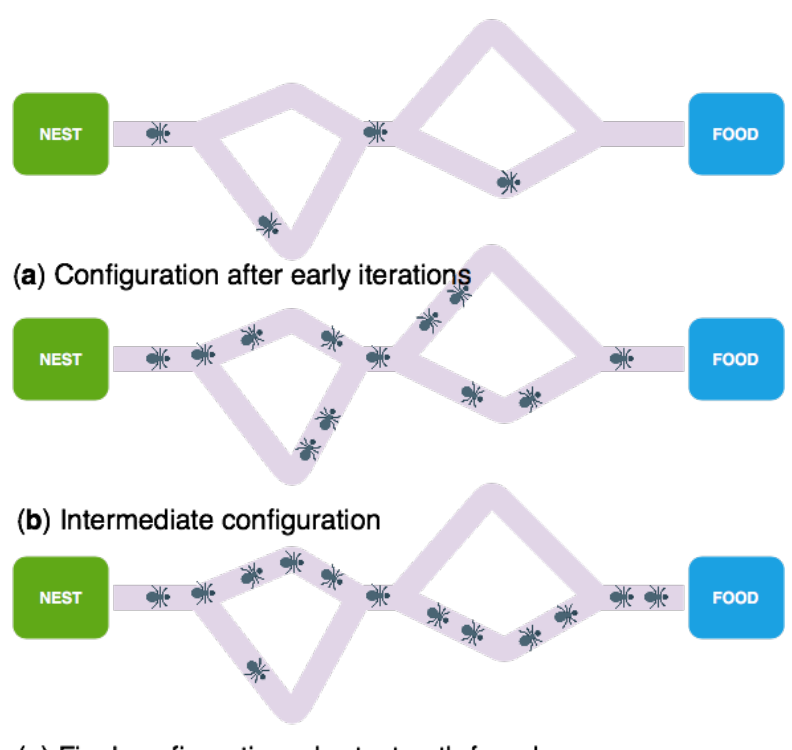
Figure 5. Goss Experiment representation (double bridge experiment). A colony of ants selecting the best route between the nest and food, ( a ) Schematic of the bridge and ants in early stages, ( b , c ) Final configuration where shortest path is found, note some “miss” ants due to the stochastic behavior of the